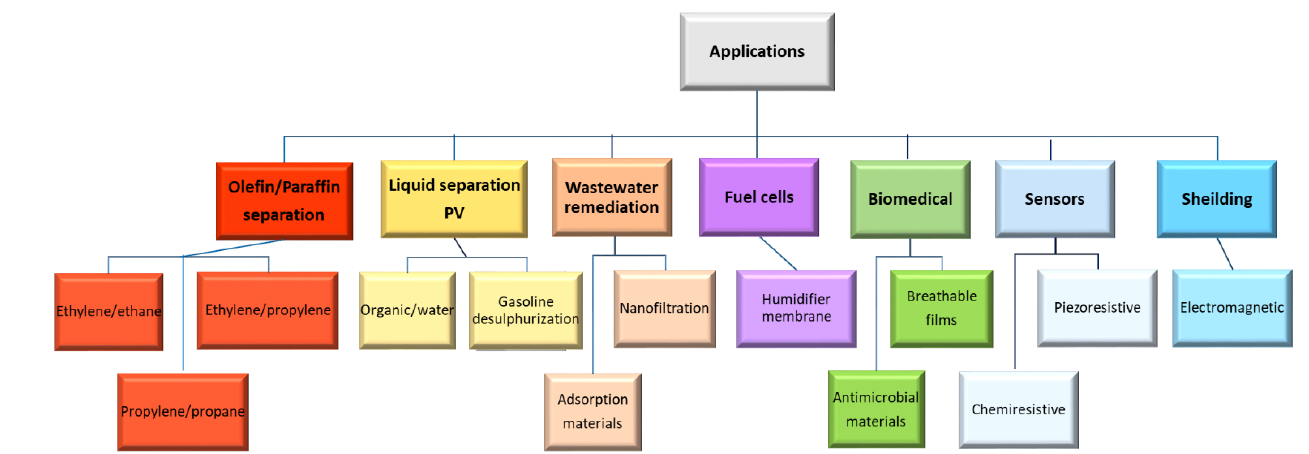
Figure 1. Categorization of Pebax-based nanocomposites on the basis of their application.